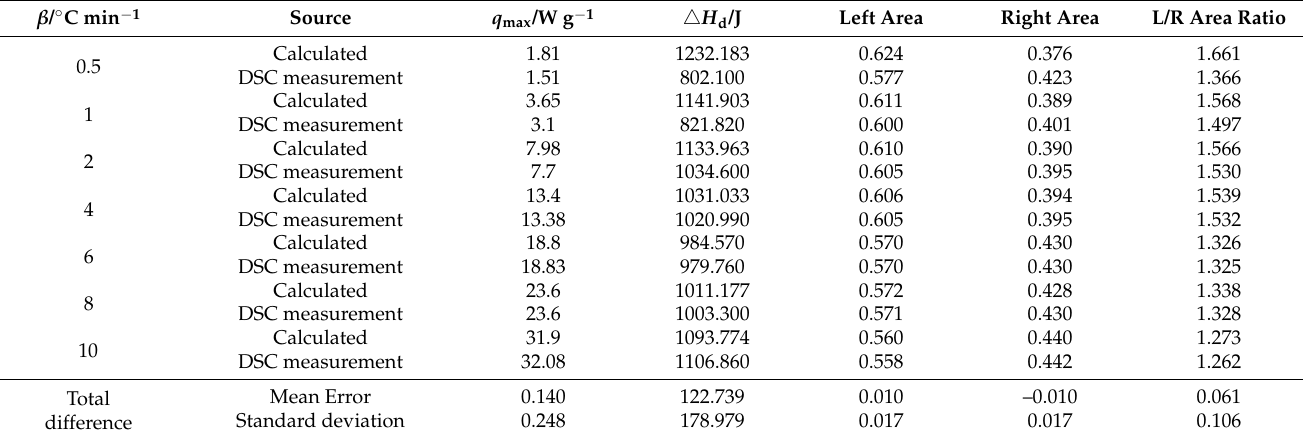
Table 2. Differences of characteristic parameter on heat between Mathematica calculated data and DSC measurement of BTBPC. (The numbers in red represent the values derived by this study that were significantly different from the DSC measurements).